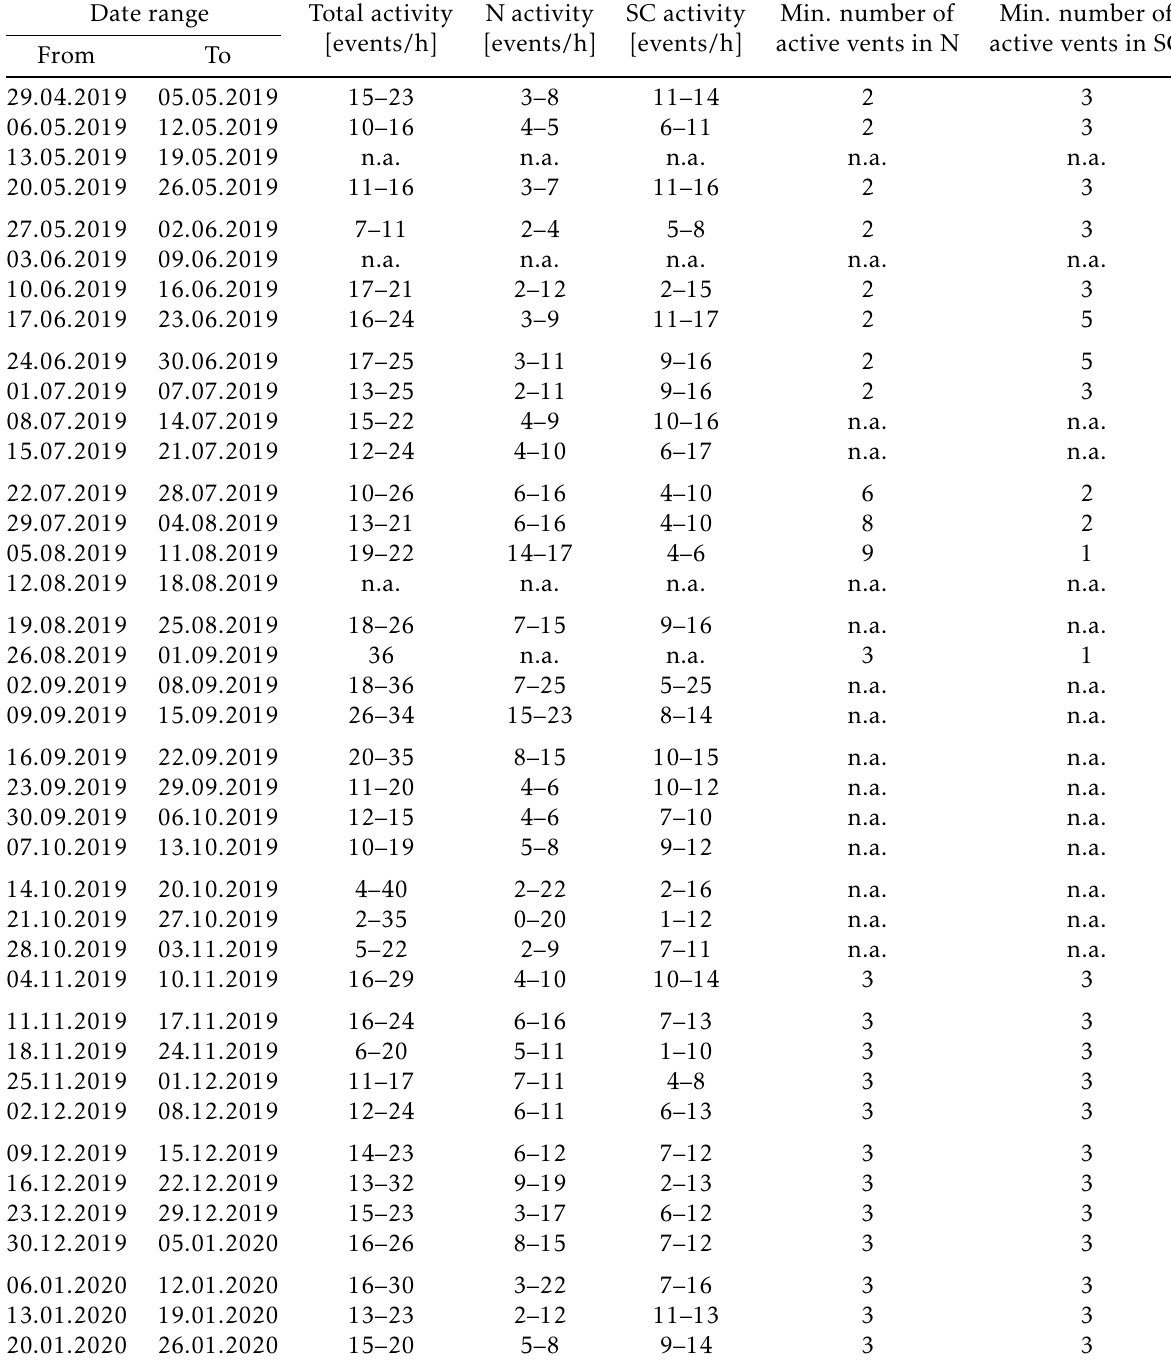
Table A3: Levels of eruptive activity between May 2019 and January 2020 as reported by the weekly and daily reports “Bollettini multidisciplinary” by INGV Osservatorio Etneo Sezione Catania a . Activity level is given as events per hour for the entire volcano and both N and SC vent areas. Where available, the minimum number of active vents is given for the N and SC vent area; n.a. indicates that data were not